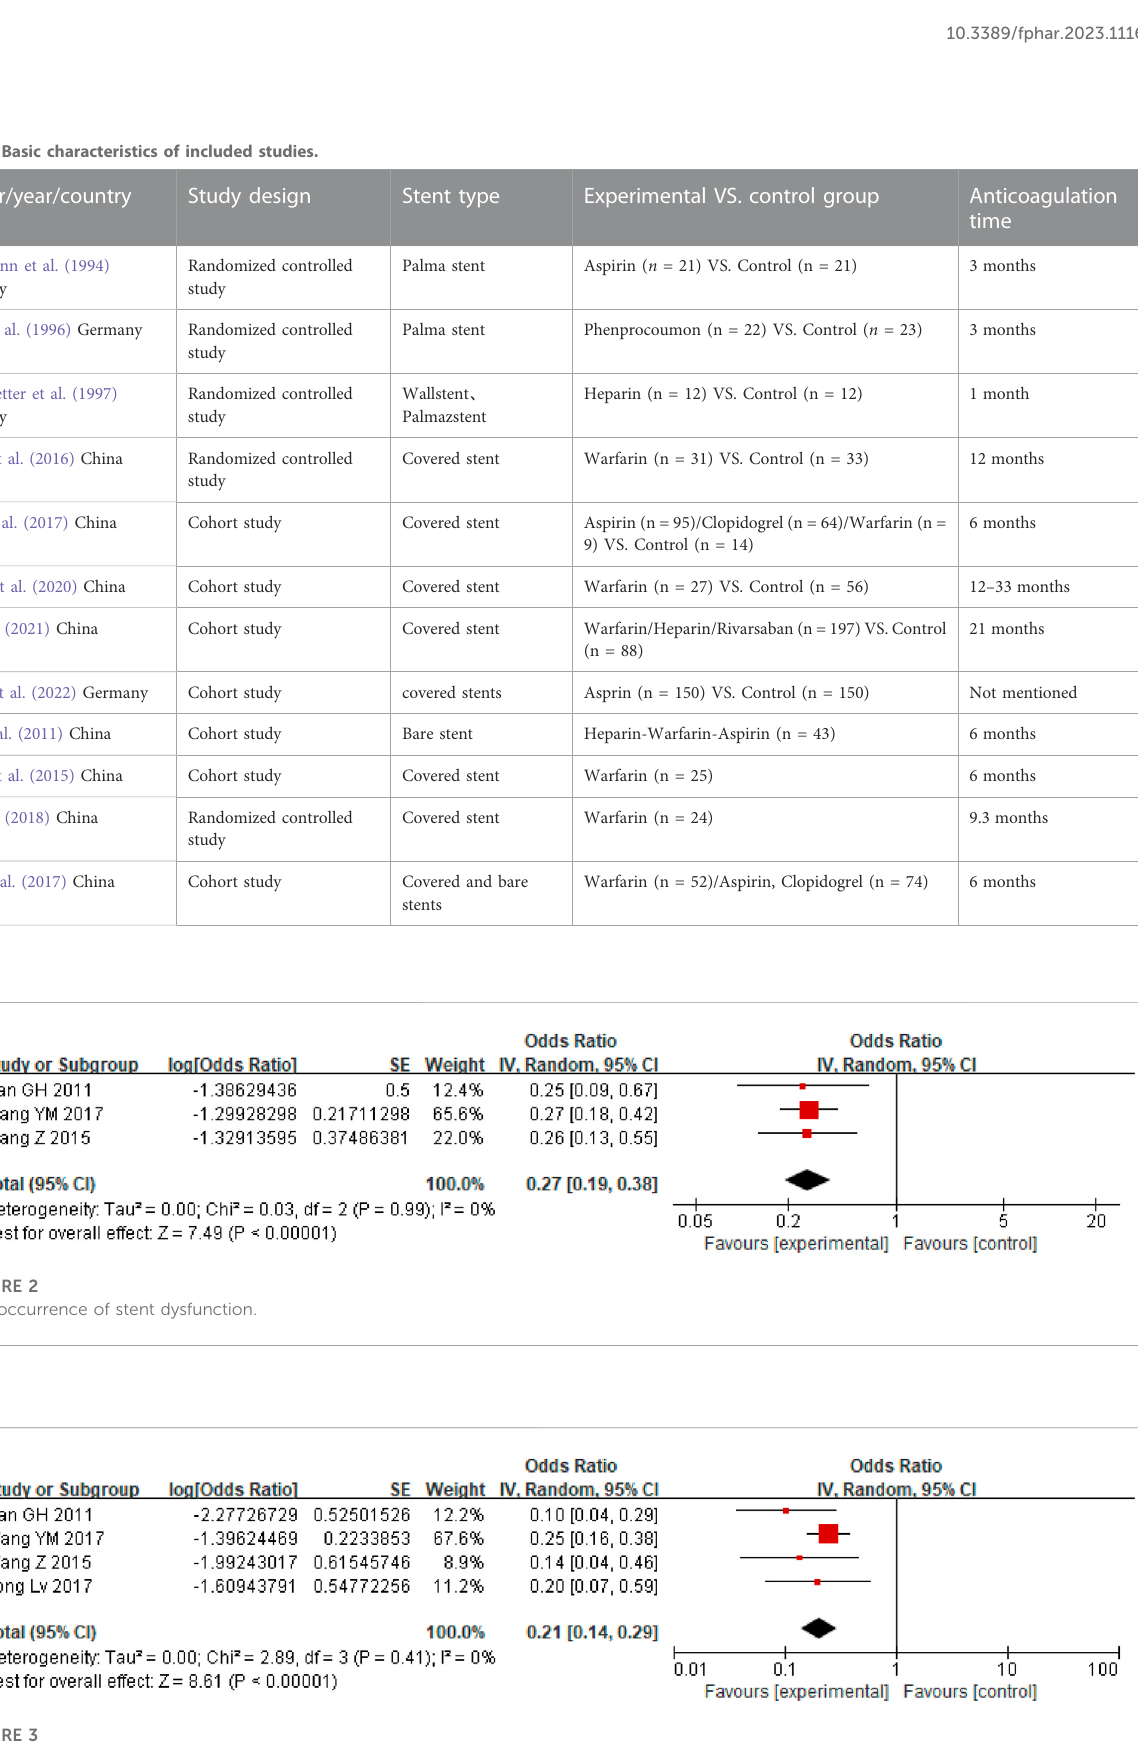
FIGURE 3 The occurrence of